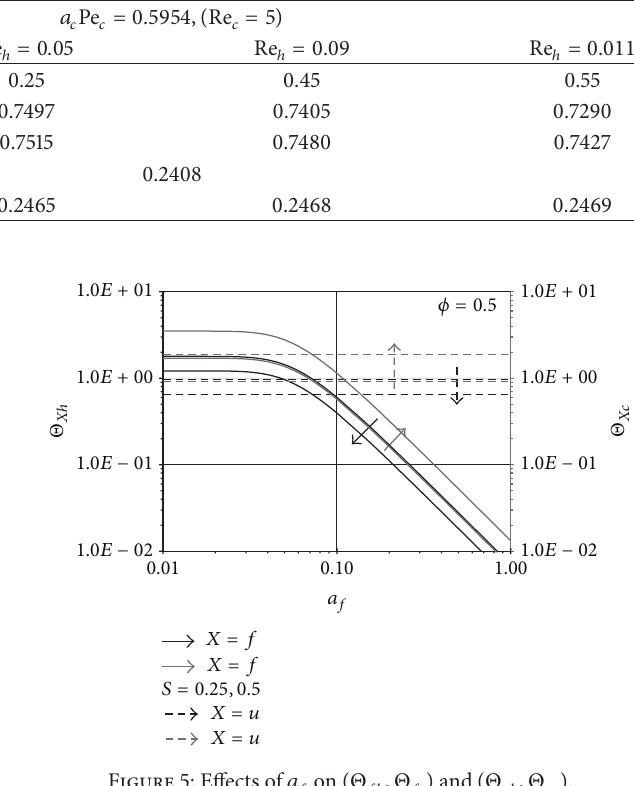
Figure 5: Effects of 𝑎 𝑓 on (Θ 𝑓ℎ , Θ 𝑓𝑐 ) and (Θ 𝑢ℎ , Θ 𝑢𝑐 ) .